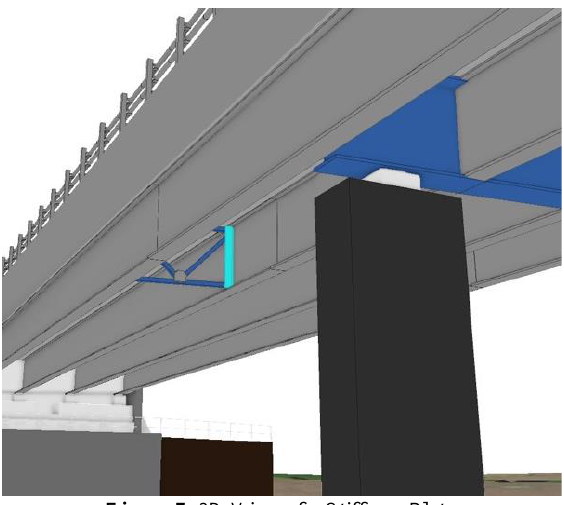
Figure 7 . 3D View of a Stiffener Plate.